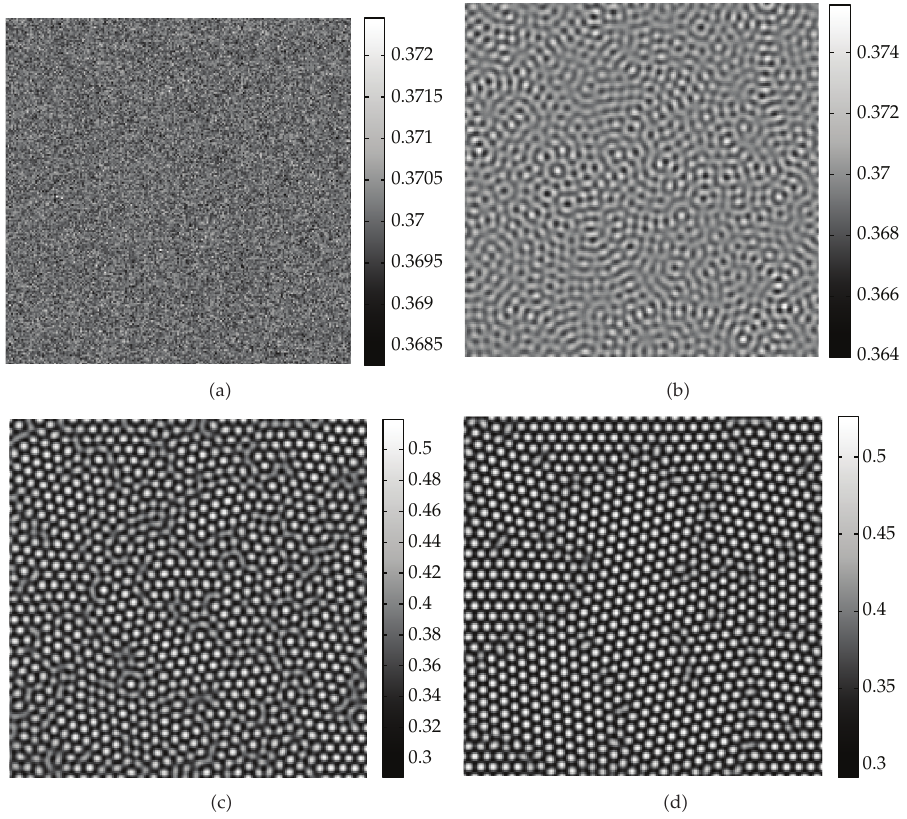
Figure 3: Spots pattern obtained with model (cid:7) 1.1 (cid:8) for (cid:7) D 12 ,r (cid:8) (cid:6) (cid:7) 0 . 12 , 0 . 1278 (cid:8) . Iterations: (cid:7) a (cid:8) 0, (cid:7) b (cid:8) 10000, (cid:7) c (cid:8) 30000, and (cid:7) d (cid:8) 300000.